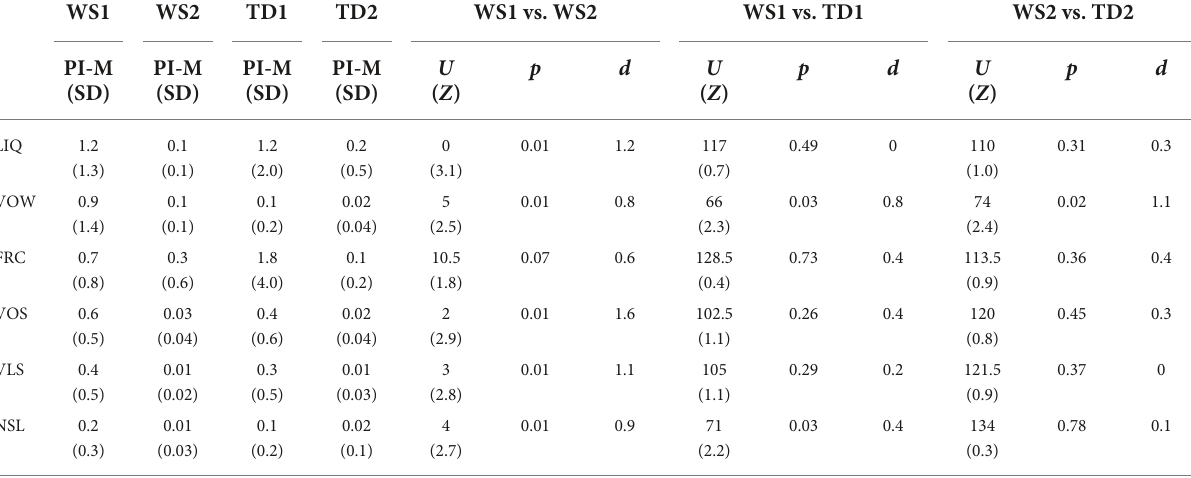
TABLE 4 Substitution phonological processes index means and standard deviations for groups, Mann–Whitney U test, and effect size.